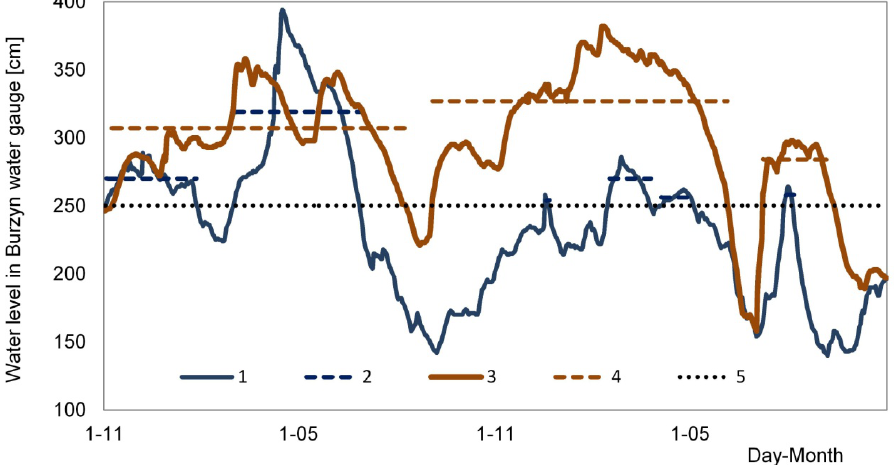
Figure 3. Example assessment of average water level for particular flood phenomenon on the basis of water level hydrograph measured on the Burzyn water gauge. Source of data: Institute of Meteorology and Water Management (IMGW). 1 water level hydrograph